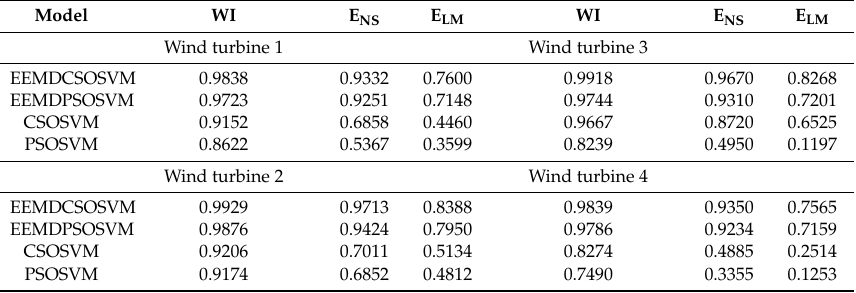
Table 3. Comparison of the value of WI, E NS , and E LM between the proposed model and some related